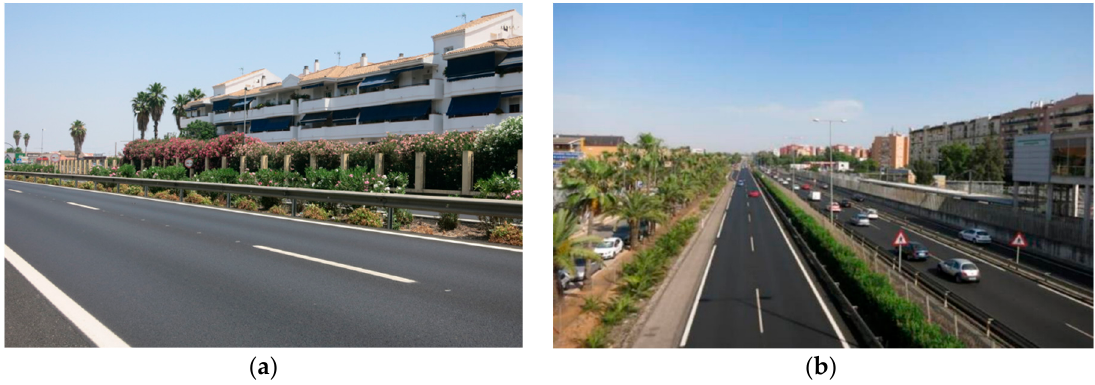
Figure 10. ( a ) Image of the road A-8058 after paving the mixtures. ( b ) The same at A-376.